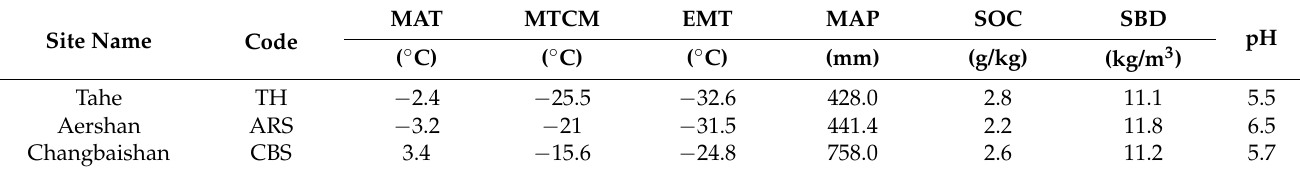
Table 4. Information on environment for 14 study sites in East Asia, where MAT = mean annual tem- perature, MTCM = mean temperature of the coldest months, EMT = extreme minimum temperature, MAP = mean annual precipitation, SOC = soil organic carbon and SBD = soil bulk